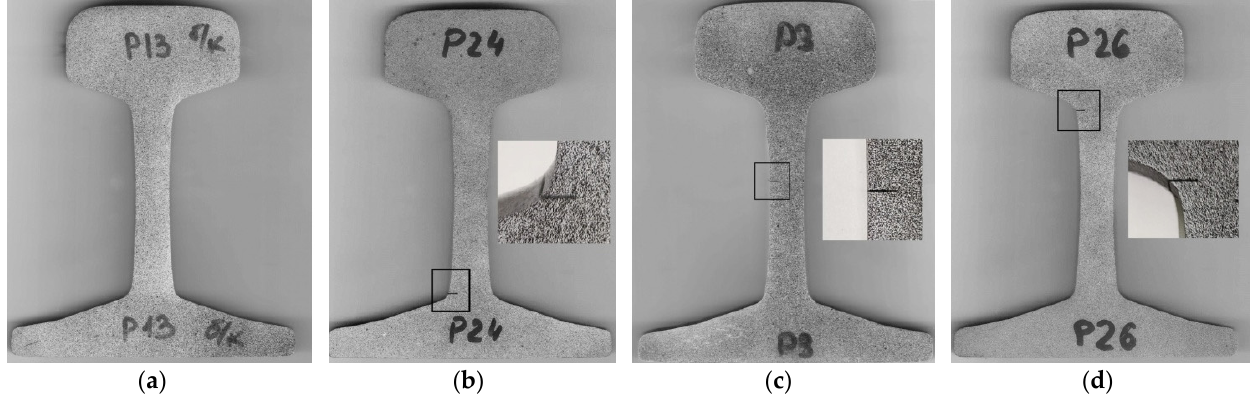
Figure 1. Samples of the rail sections without ( a ) and with incision in the foot ( b ), web ( c ) and head ( d ).